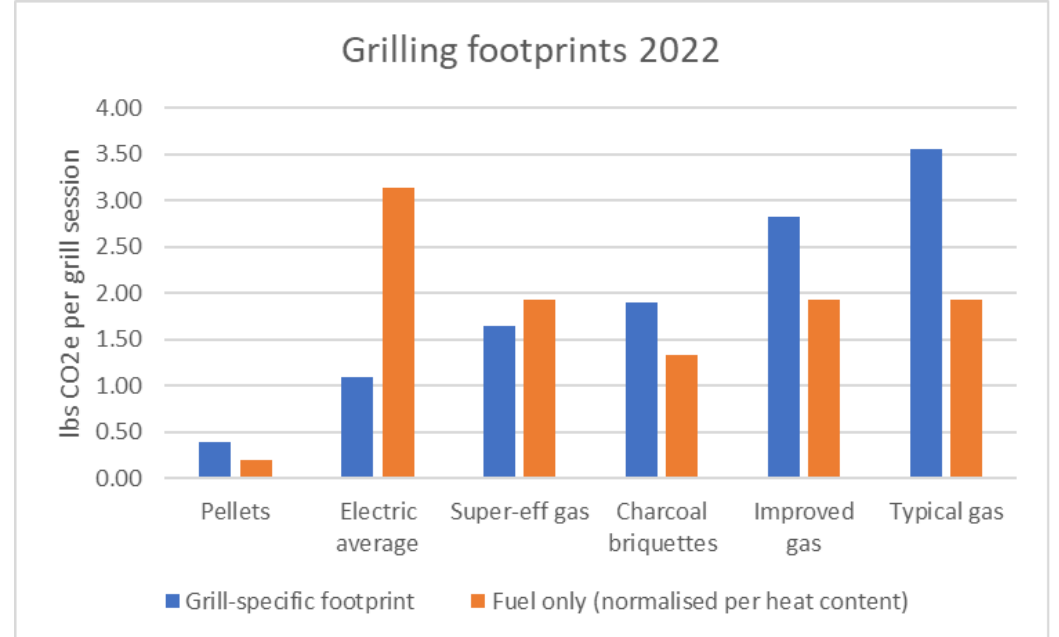
Figure 2. Carbon footprints for grills, grill-specific and fuel-only, USA 2022.